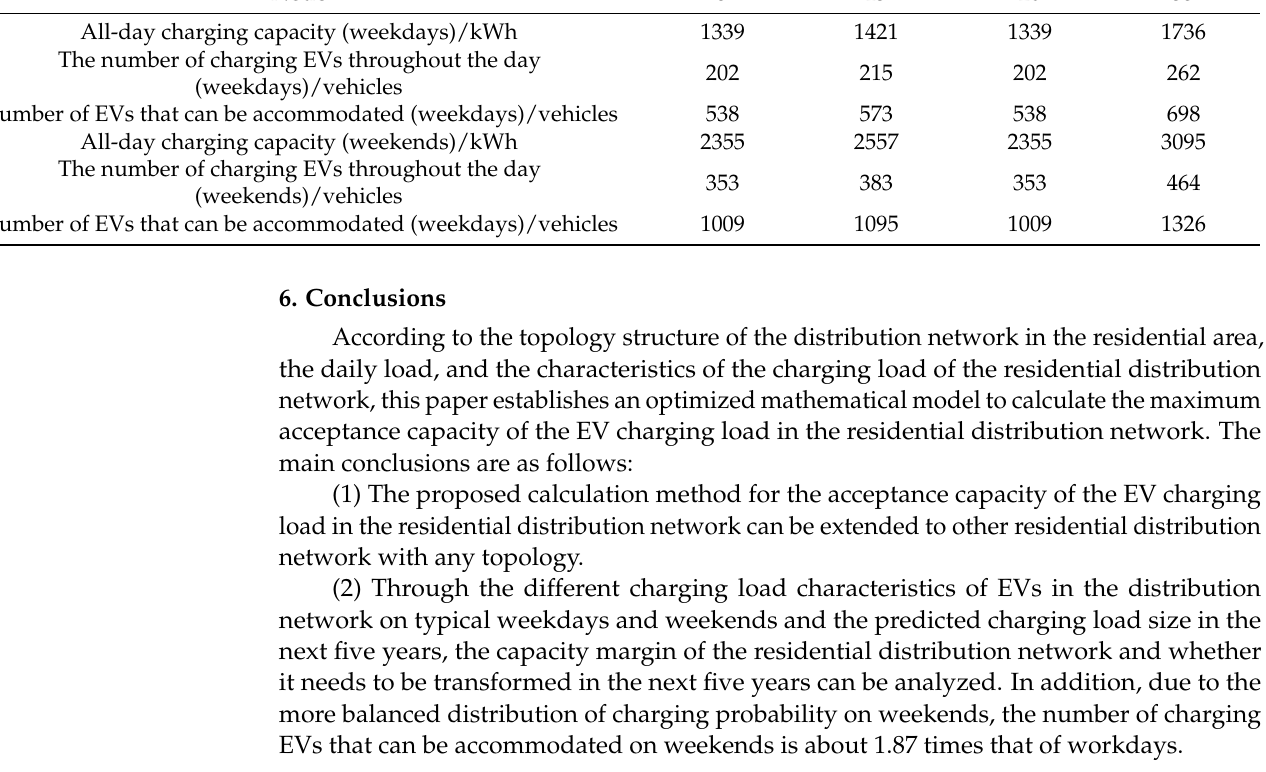
Table 5. Priority of EV access nodes in each power supply area.